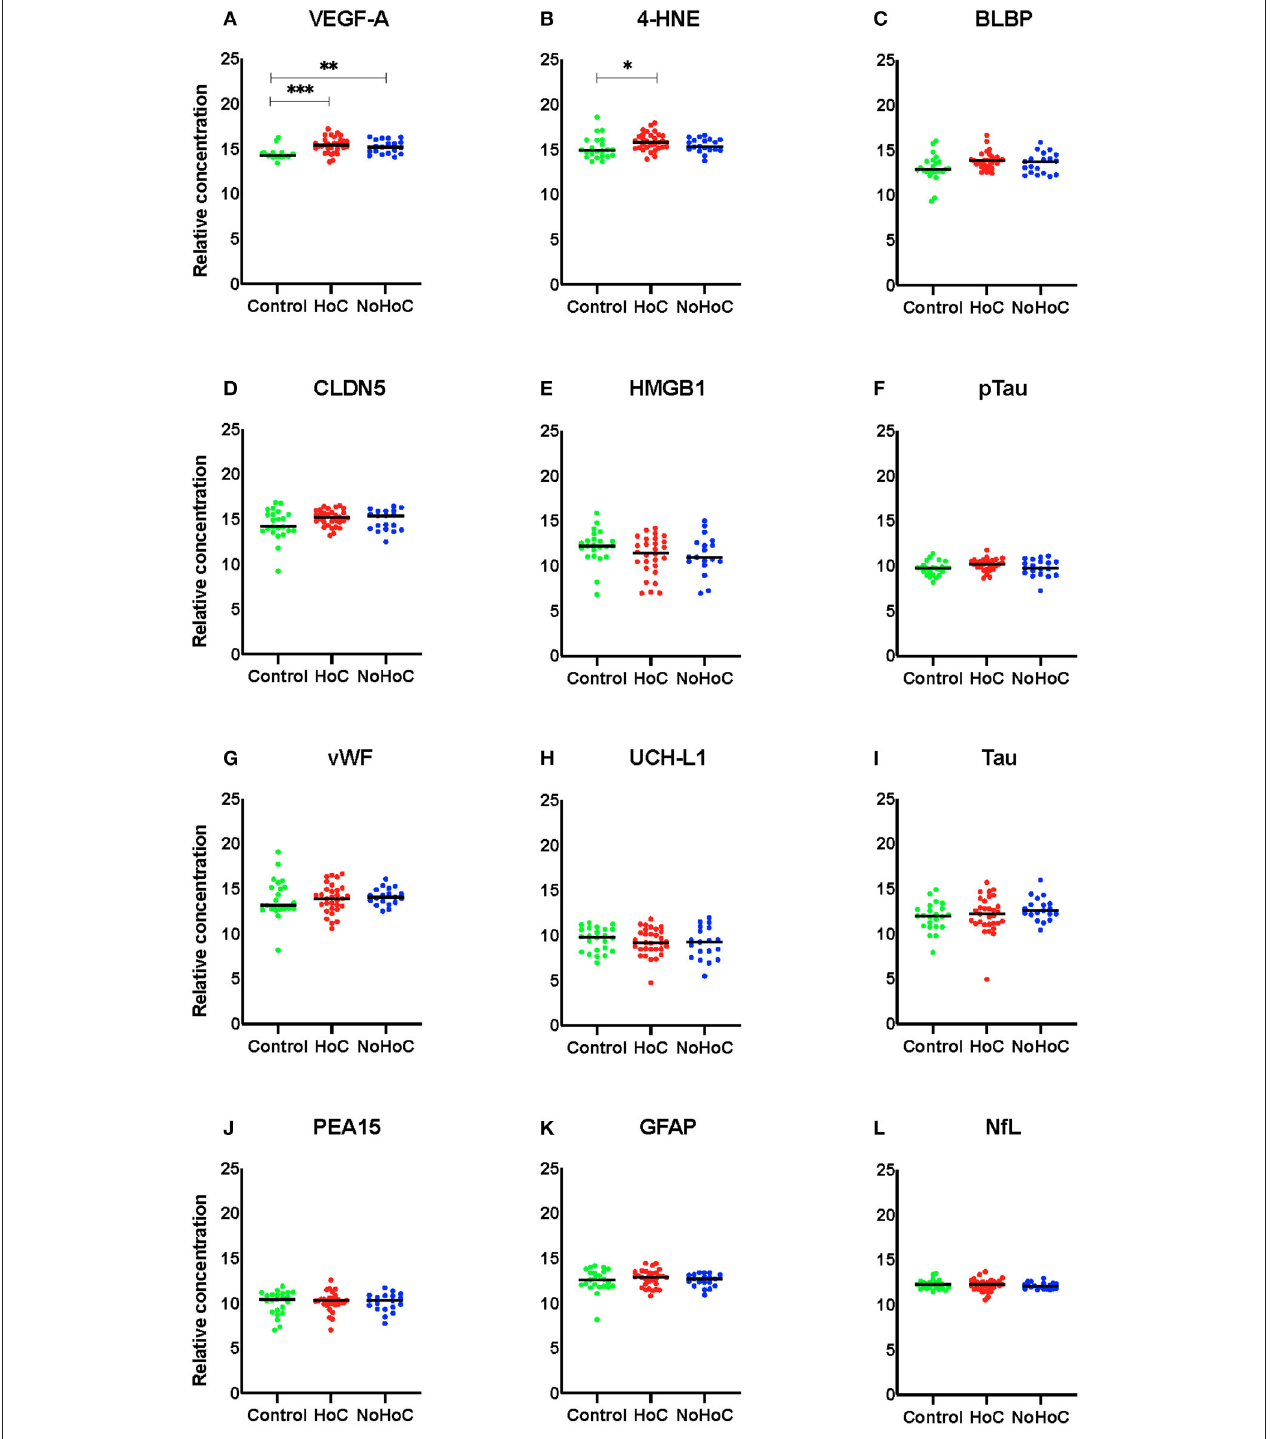
FIGURE 1 | Serum protein levels in male participants. (A) Both the HoC and NoHoC groups had significantly greater concentrations of VEGF-A compared to the control group (** P < 0.01, *** P < 0.0001). (B) The HoC group had significantly greater concentrations of 4-HNE compared to the control group (* P < 0.05). (C–L) There were no other significant findings on the remaining